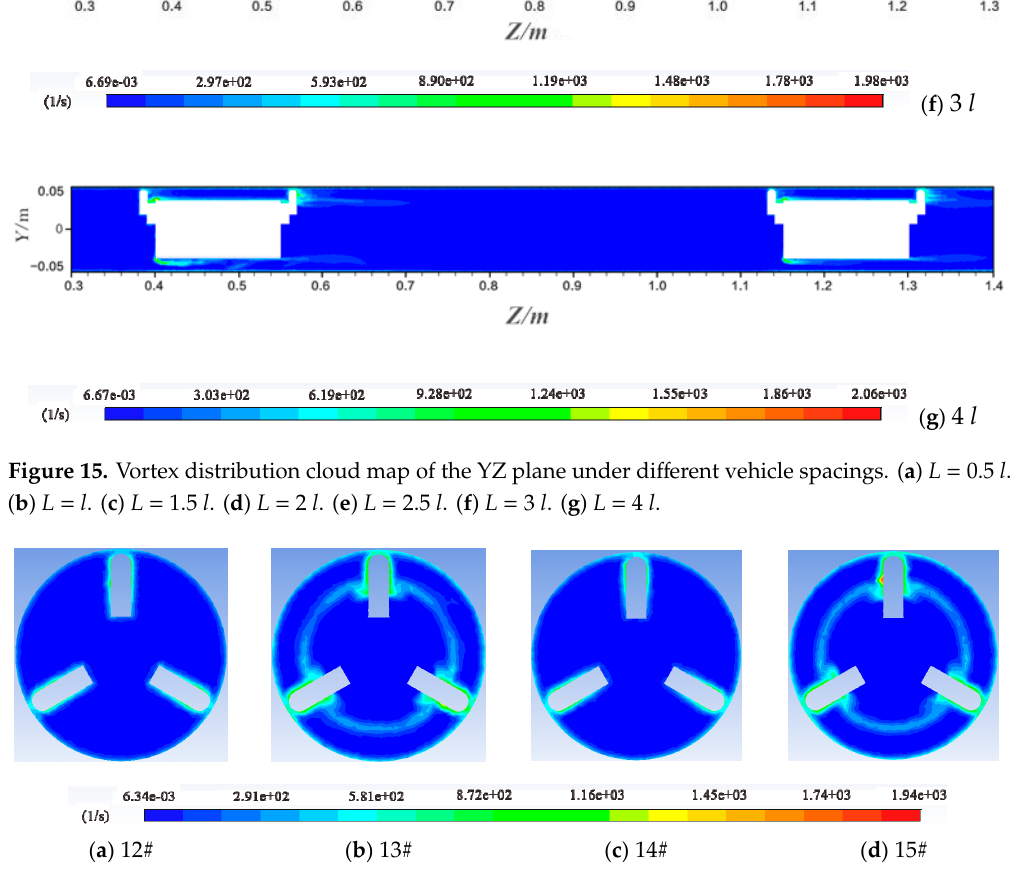
Figure 16. Vortex magnitude distribution cloud map of the support body cross-sections with 0.5 l vehicle spacings. ( a ) Vorticity at 12# section. ( b ) Vorticity at 13# section. ( c ) Vorticity at 14# section. ( d ) Vorticity at 15# section. Note: 12# and 13# represent the cross-section of the support body of the left pipe vehicle; 14# and 15# represent the cross-section of the support body of the right pipe vehicle.